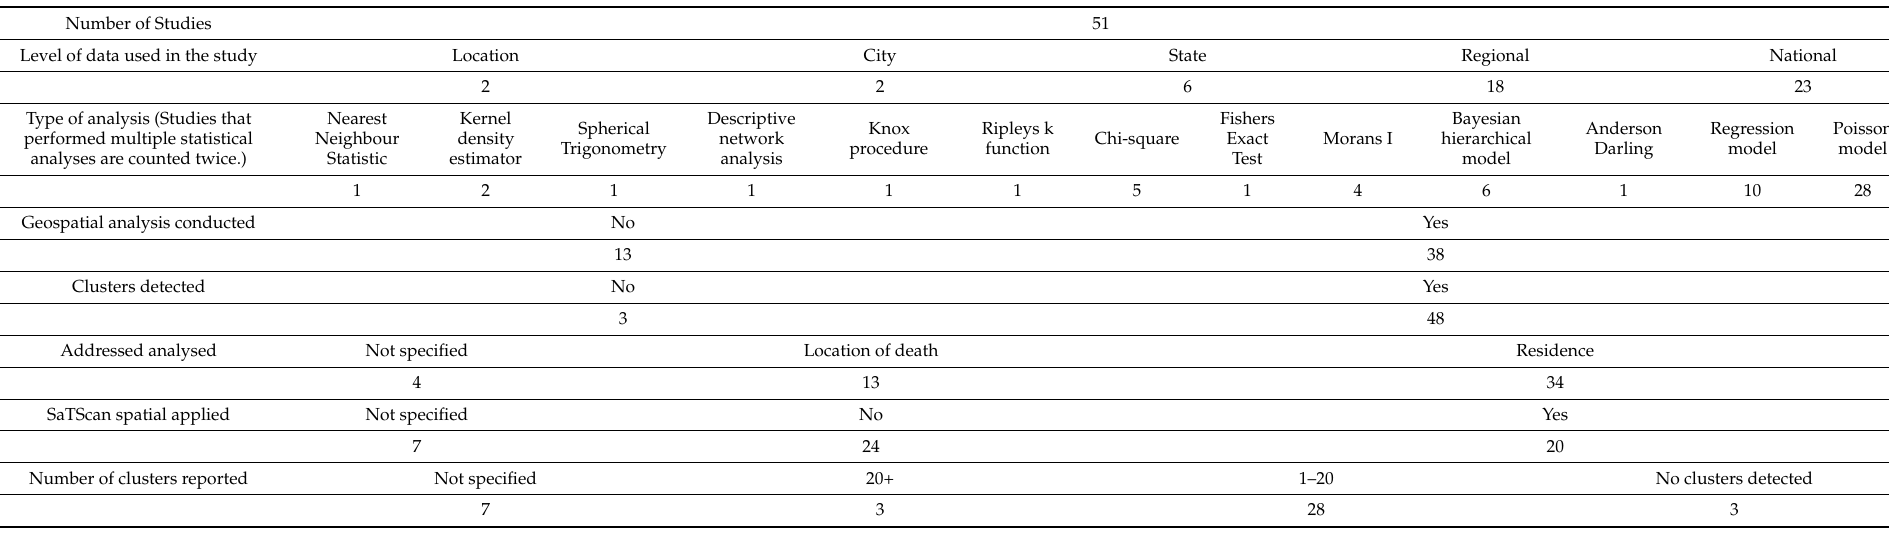
Table 1. Point suicide clusters.